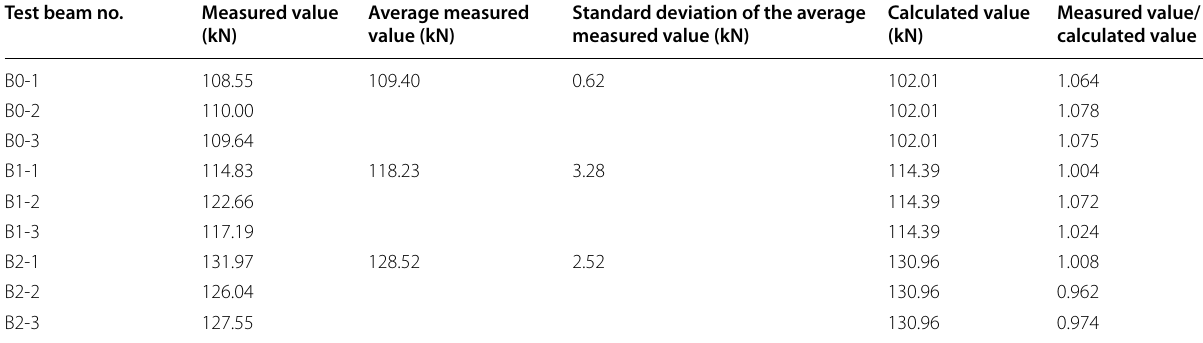
Table 7 Comparison between calculated and measured shear capacity of beam sections. Test beam